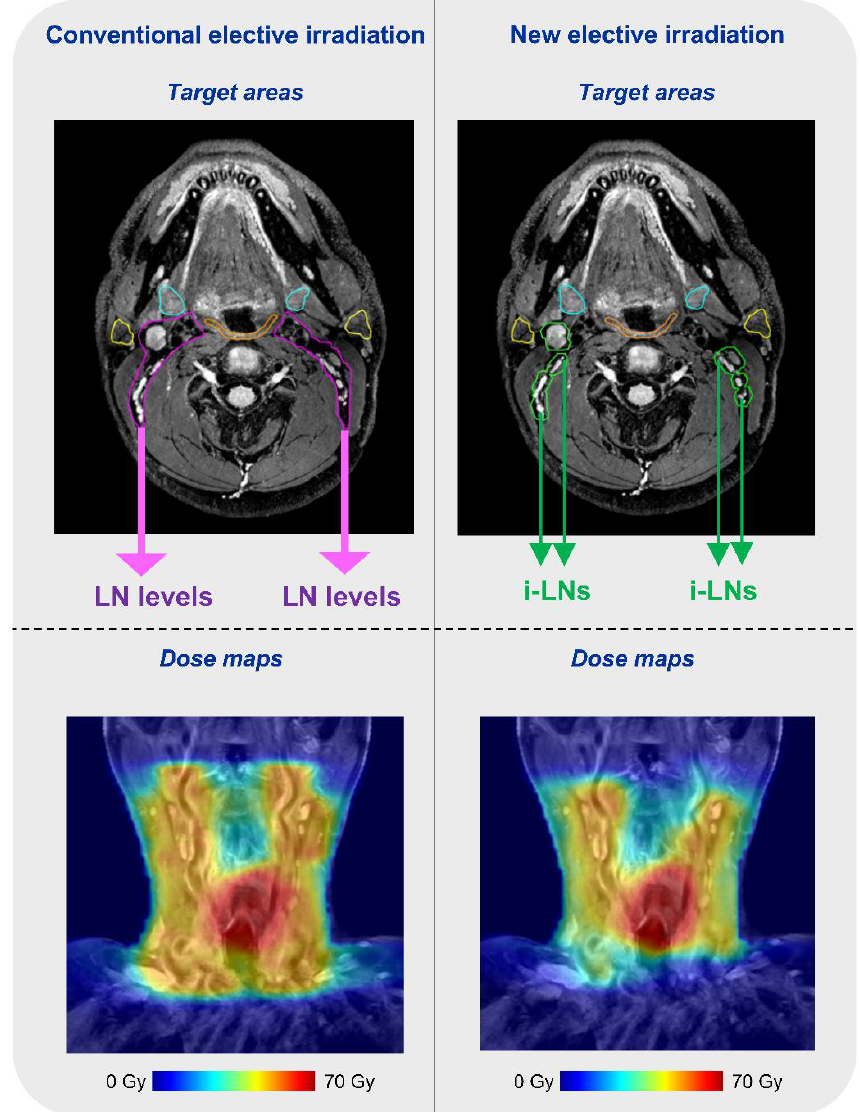
Figure 4. Lymph node-level (upper left) and individual lymph node (upper right) delineation of a head and neck cancer patient with corresponding dose distributions (below).